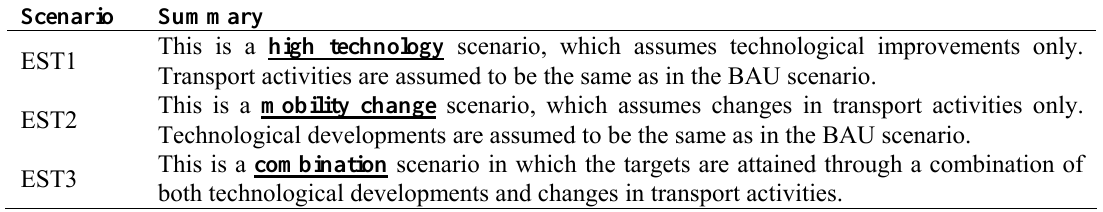
Table 2. Interrelations among the scenarios